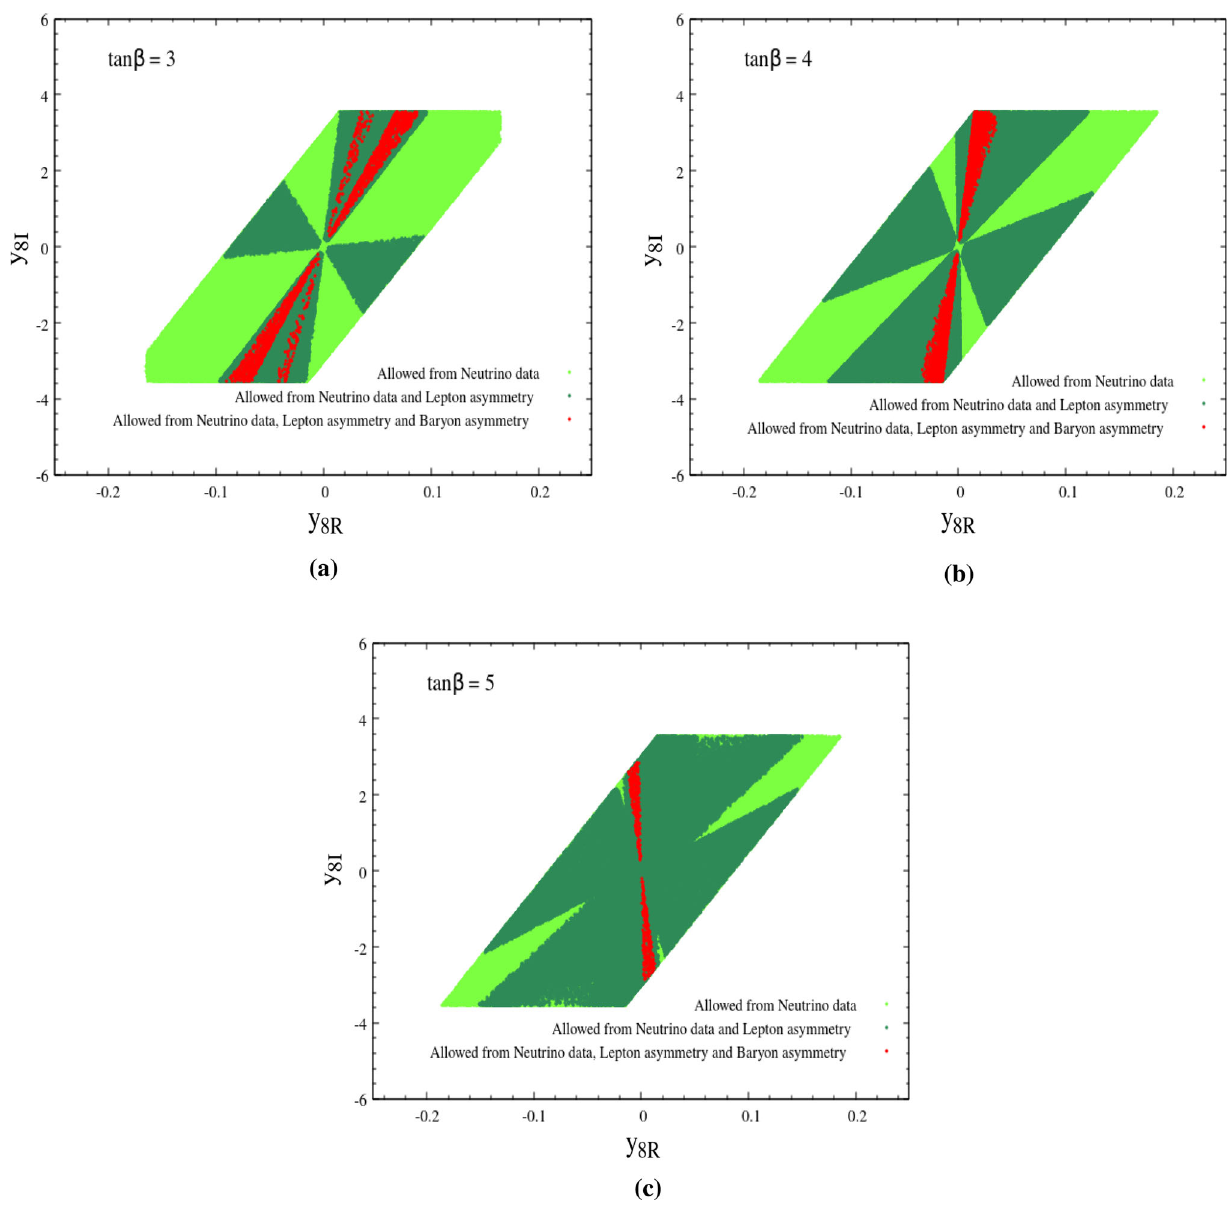
Fig. 10 Parameterspace inreal vs. imaginary part of Yukawa coupling y 8 . Plots are given for tan β = 3 (upper panel left), tan β = 4 (upper panel right), tan β = 5 (lower panel). Light green, deep green and